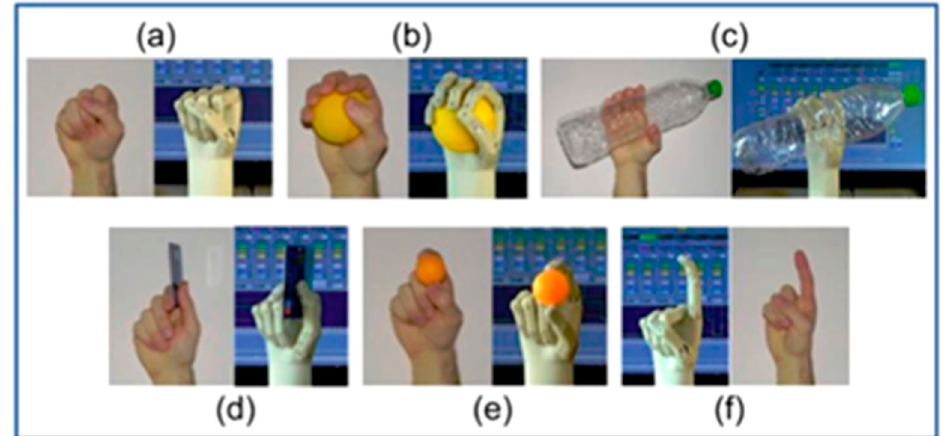
Figure 5. Di ff erent postures of a real human hand vs. the artificial hand Figure 5. Different postures of a real human hand vs. the artificial hand [21].